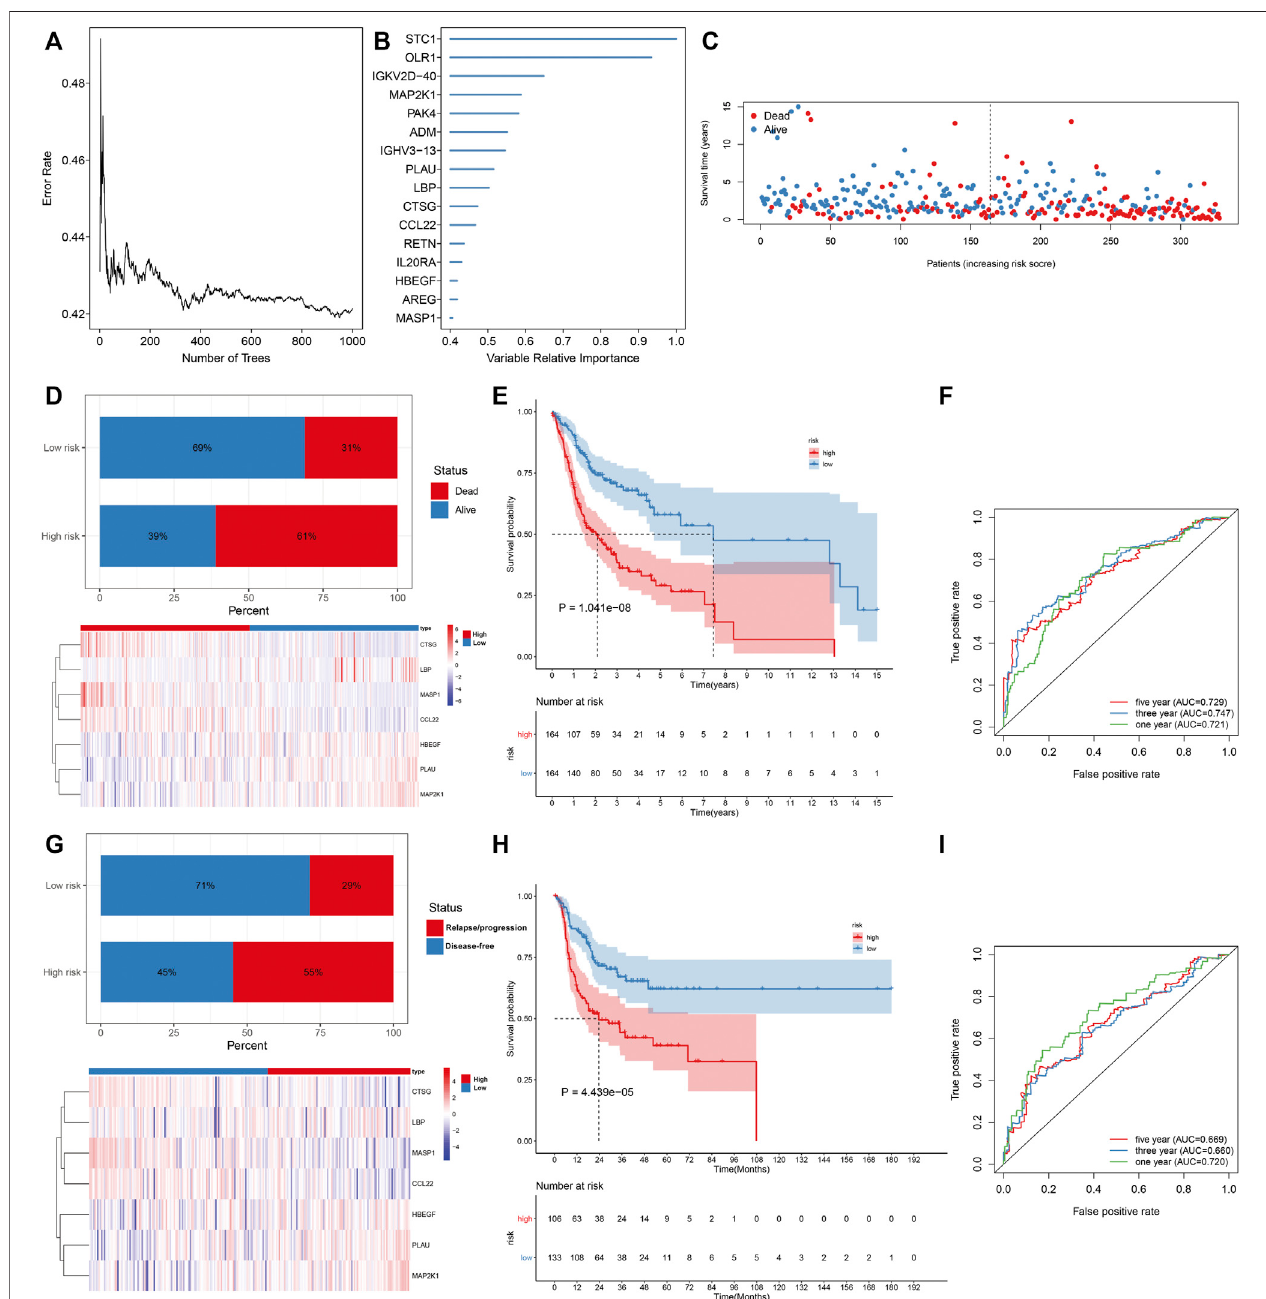
FIGURE 1 | Construction of an IRS model for prediction of OS and DFS of OSCC in the TCGA cohort. (A) Associations of error rate with number of classi fi cation trees. (B) Relative importance ranking of 15 out-of-bag genes. (C) Visualization of survival time of each OSCC patient. (D) Distribution of survival status and expression patternsof characteristic IRGs in high- and low-risk groups. (E) The K – M curves of OS between two groups. (F) ROC curves at 1-, 3-, and 5-year OS based on the IRS. (G) Distributionofdisease-freestatusandexpressionpatternsofcharacteristicIRGsinhigh-andlow-riskgroups. (H) TheK – McurvesofDFSbetweentwogroups. (I) ROC curves at 1-, 3- and 5-year DFS based on